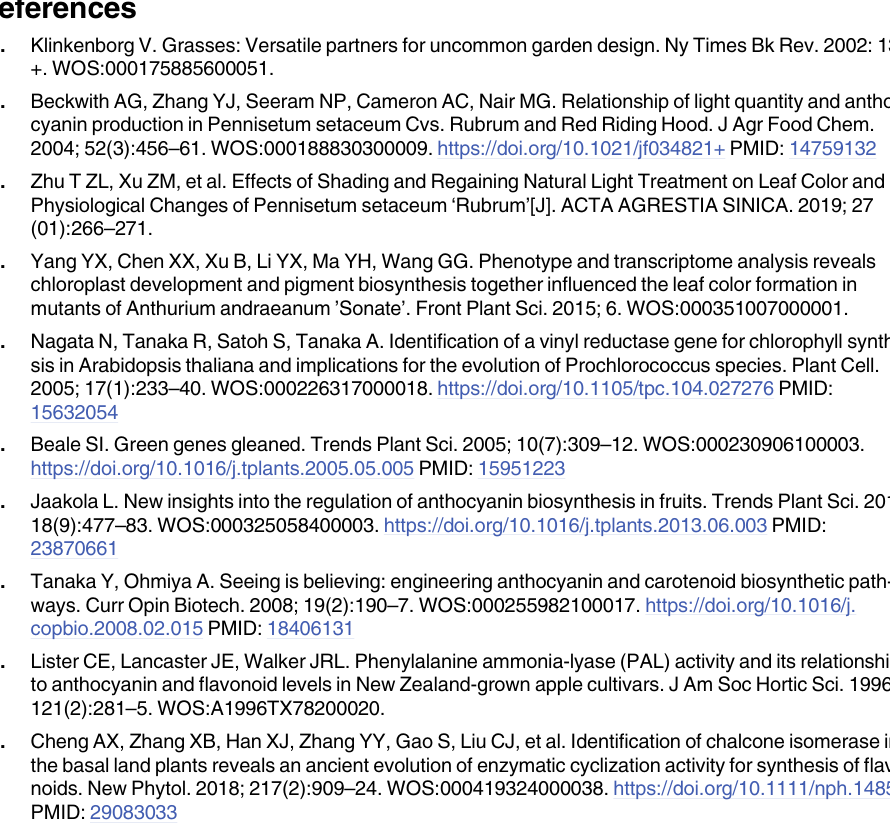
S2 Fig. Statistics of gene coverage for six samples of Pennisetum setaceum ‘Rubrum’.